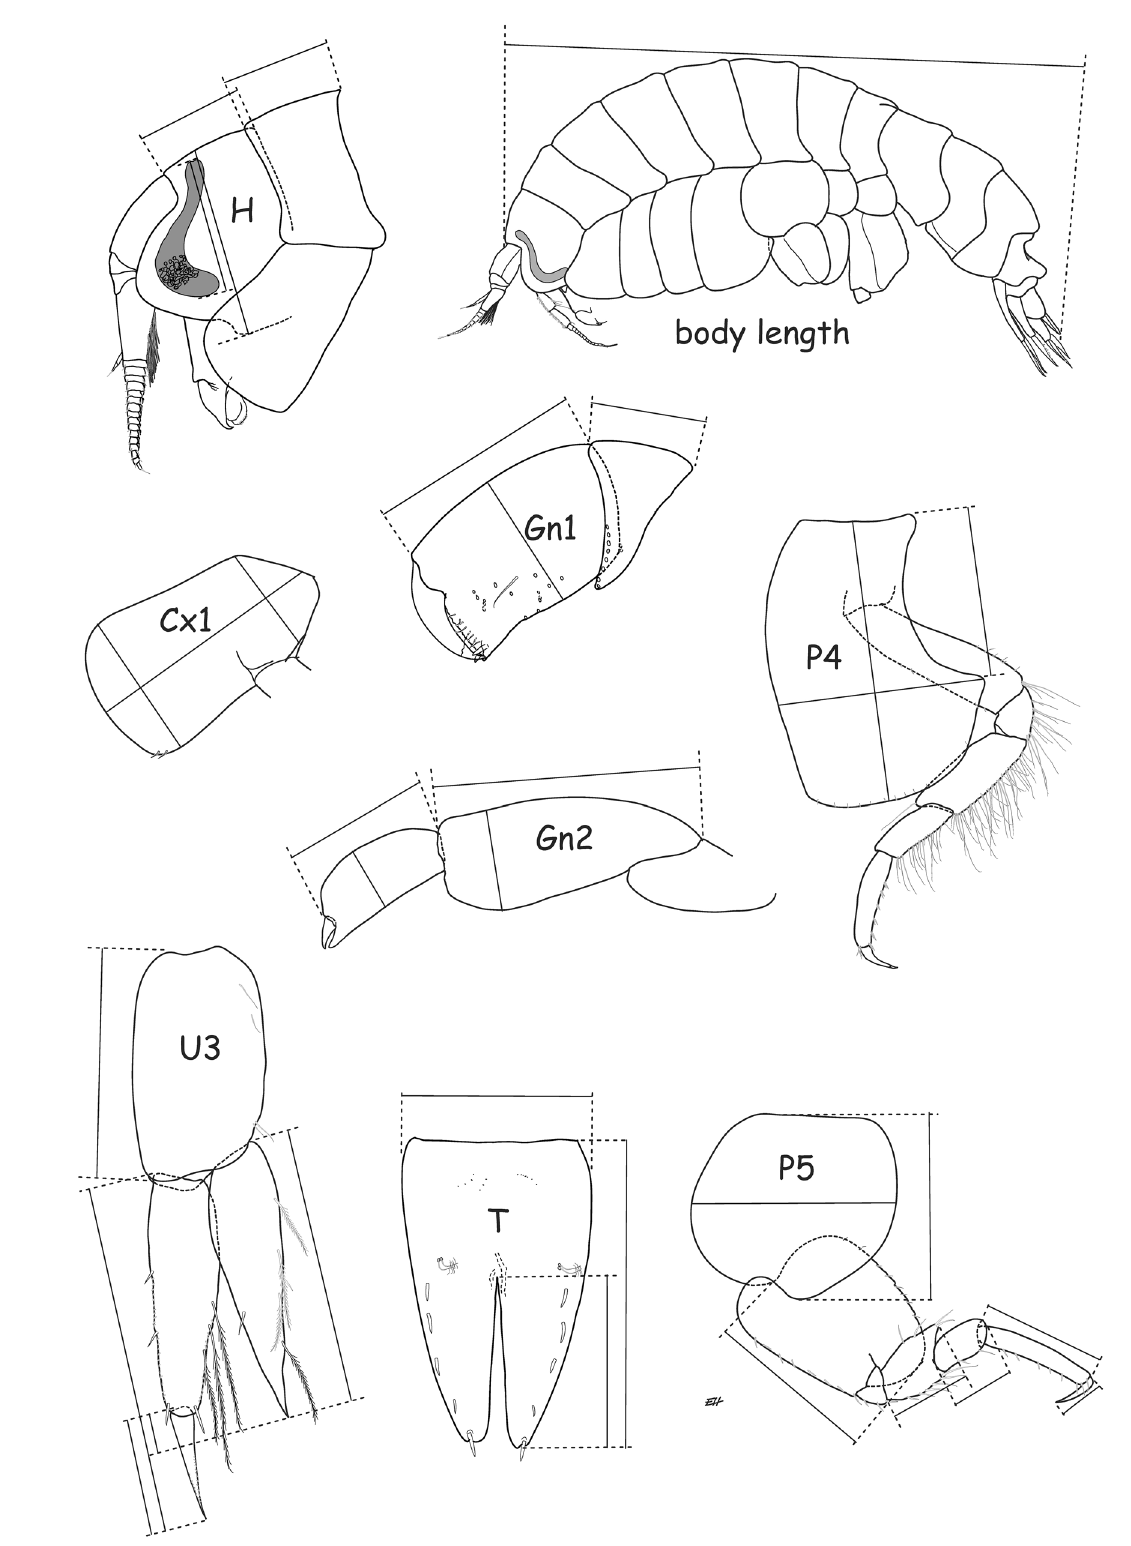
Fig. 1. Measuring standards used in